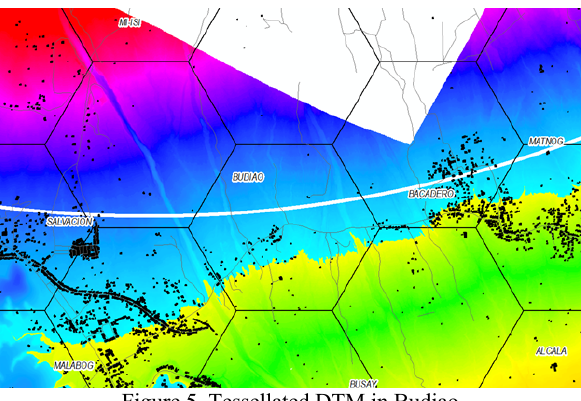
Figure is a product of Phil-LiDAR 1 Program licensed to Bicol University overlaid with OSM Buildings, Mayon Permanent